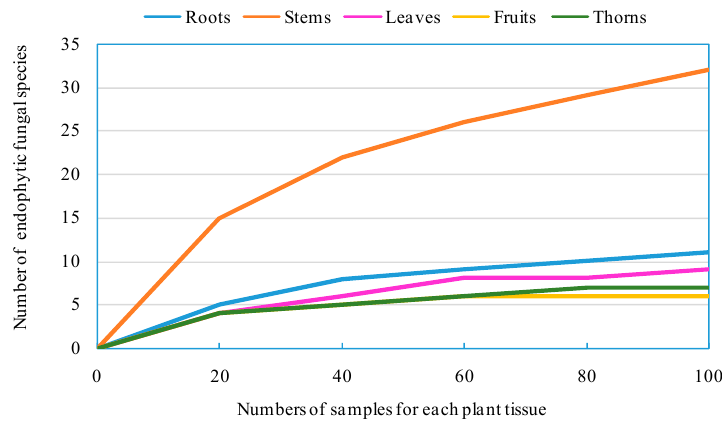
Figure 4. Rarefaction curves of endophytic fungal species for different tissues of Z. bungeanum .